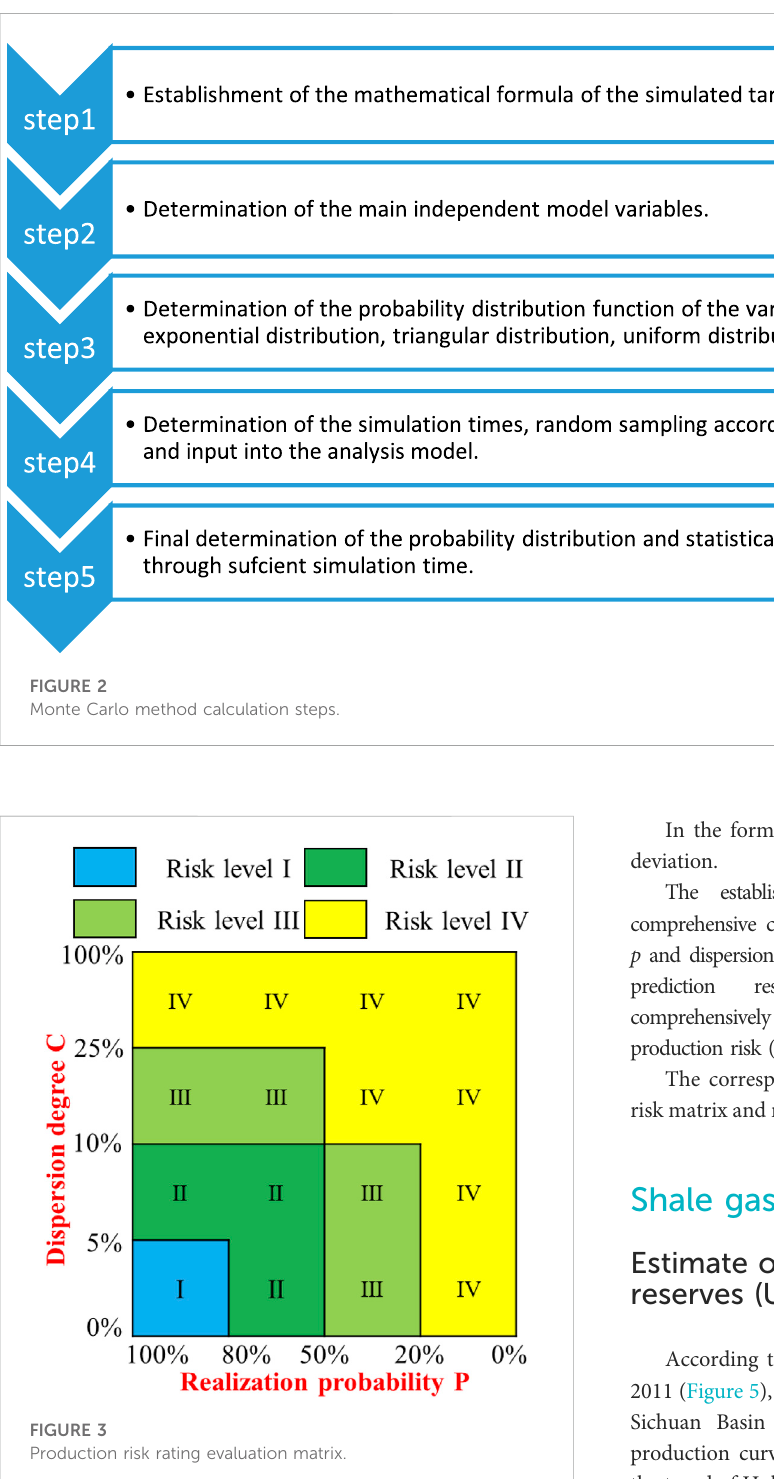
FIGURE 3 Production risk rating evaluation